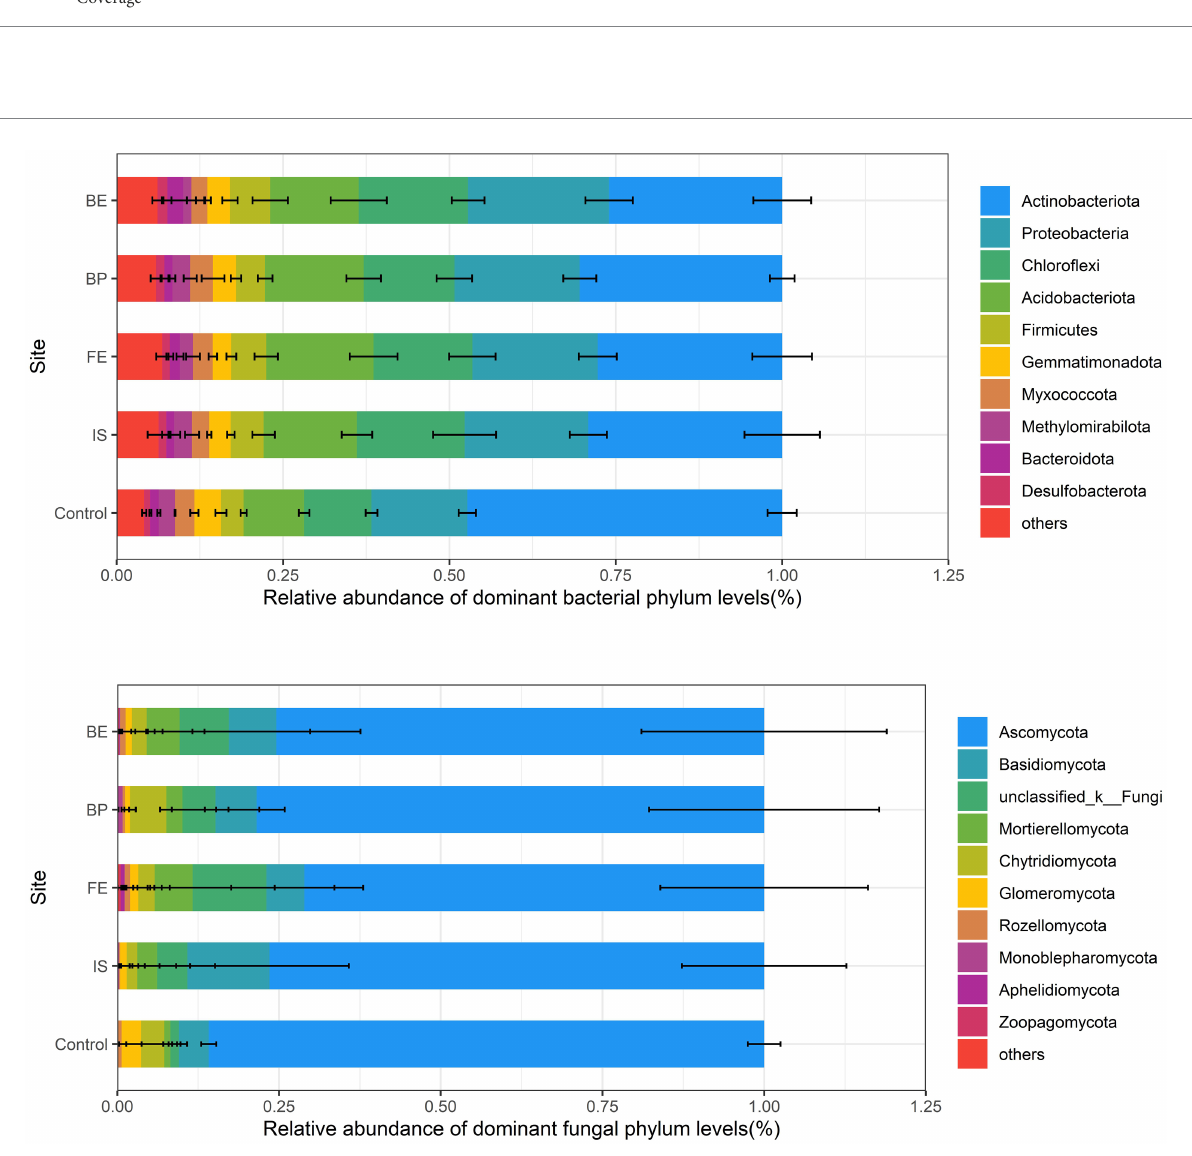
FIGURE 3 Relative abundance of dominant phyla of soil bacteria and fungi at different sites of PV